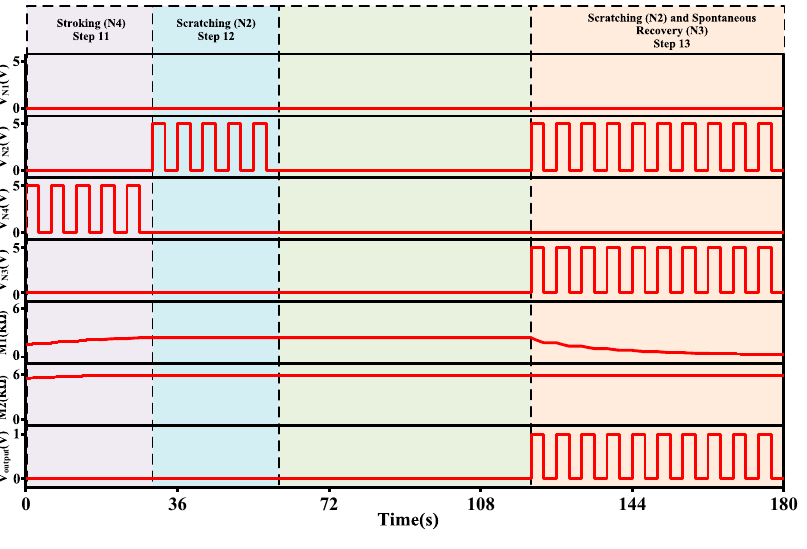
Figure 12. The transient response of Step 11 to Step 13.